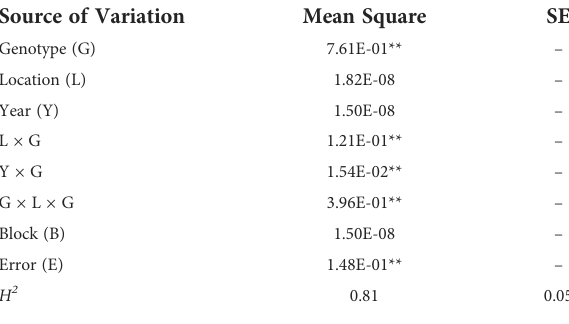
TABLE 1 Combined analyses of variance for protein in Ji846 ×